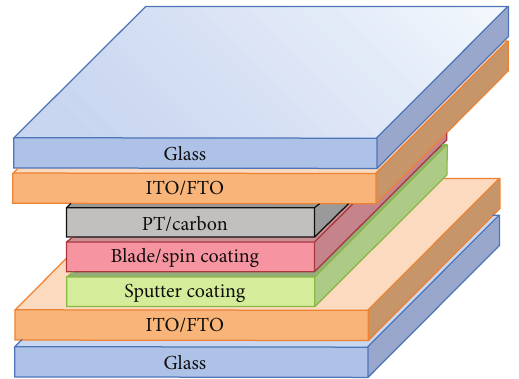
Figure 1: The structure of an assembled DSSC with a sputtered compact TiO 2 layer/FTO/glass and other layers.